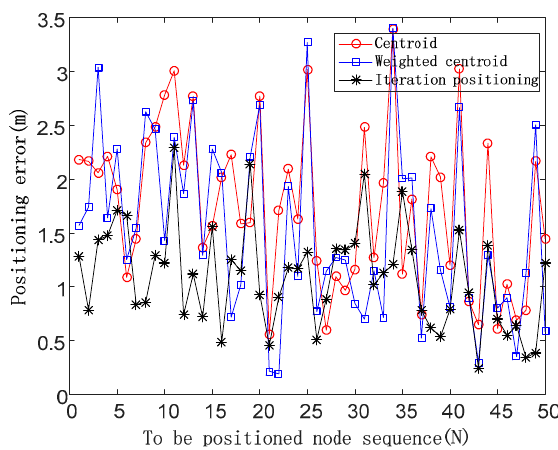
Figure 9. Positioning errors of three positioning algorithms in the case of the noise impact factor of a random value.